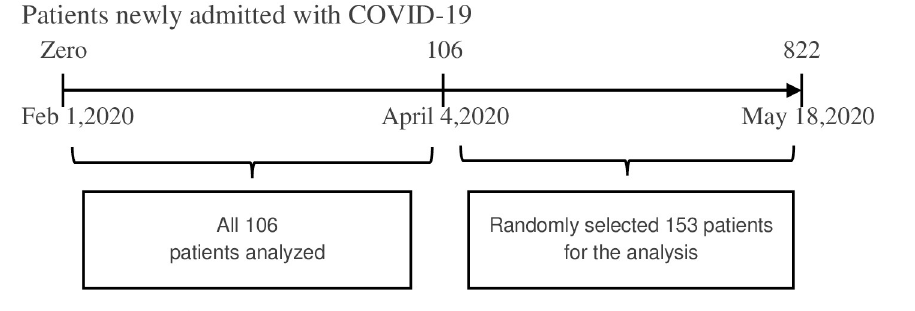
Fig 1. Participant selection: N =